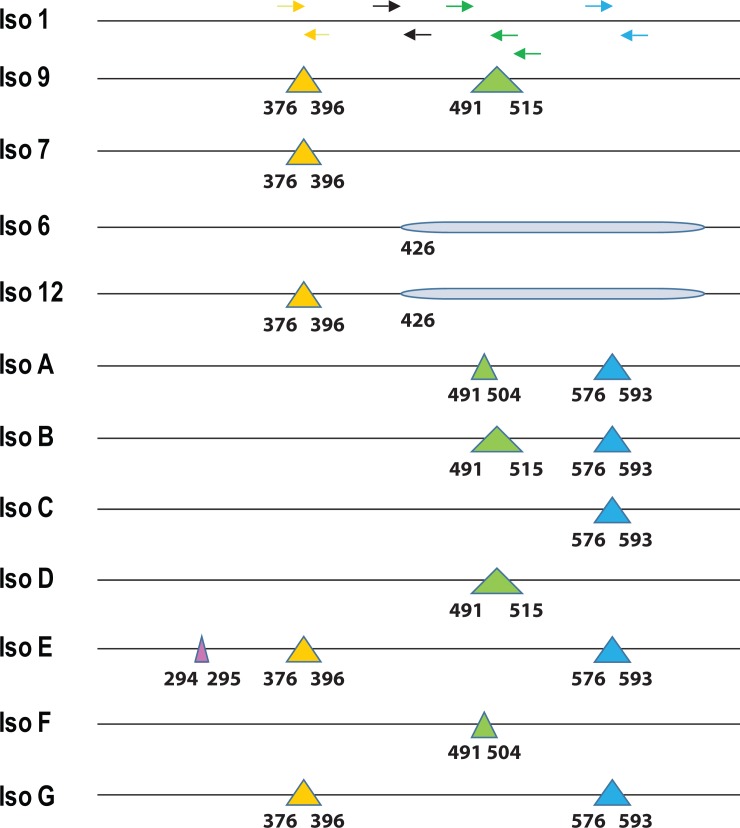
Schematic representation of the primer sets.Triangles in color indicate the deletion of amino acids at specific residue positions. Arrowheads show the position and direction of each primer. Region in shade suggests a frame shift due to alternative splicing in isoform 6 and 12.